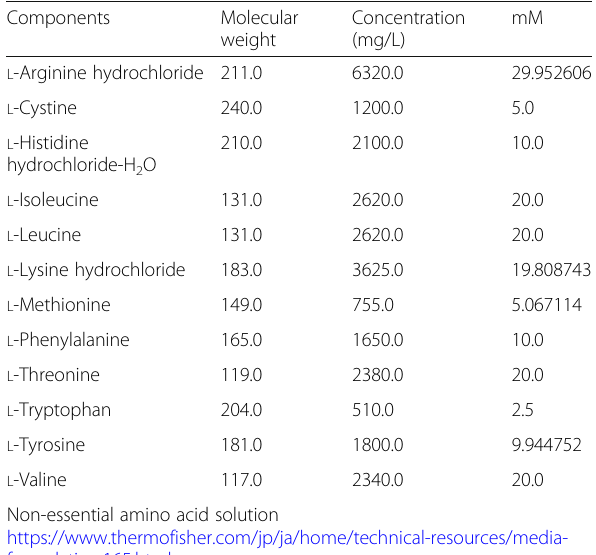
Table 1 Constituent of essential and non-essential amino acid